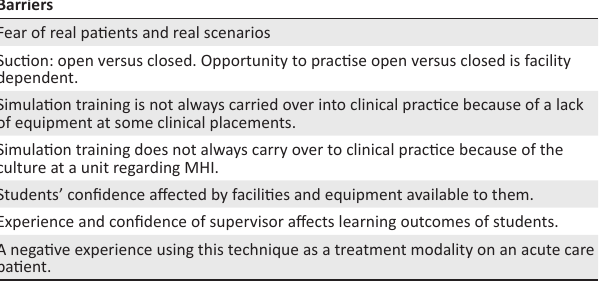
TABLE 4: Barriers to skills implementation into clinical practice.